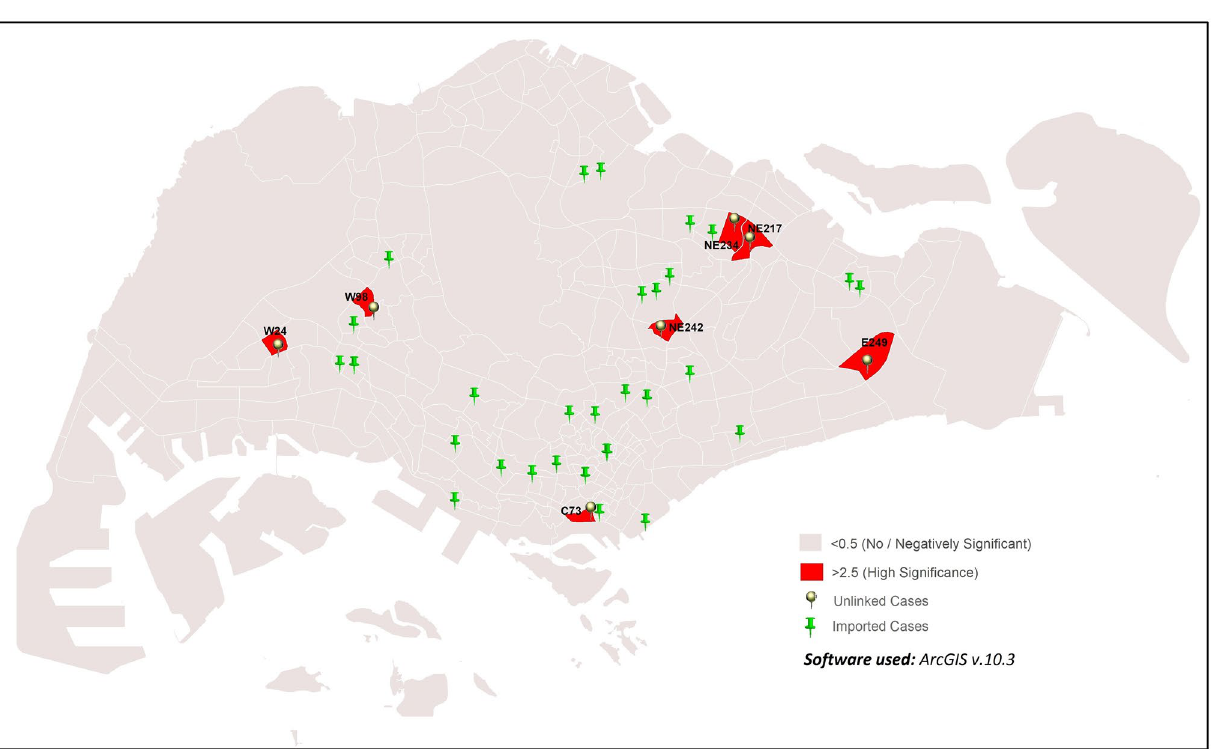
Figure 9. Distribution sub-zones with correlation of imported and unlinked